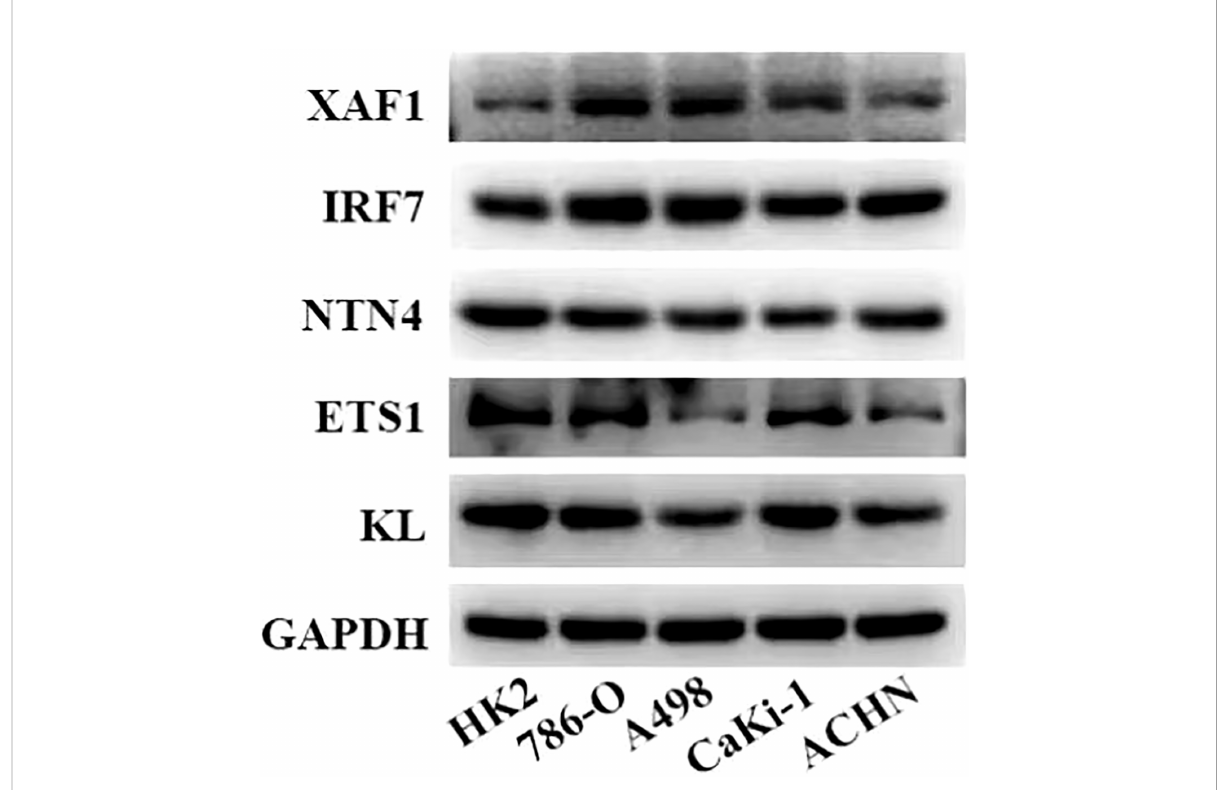
FIGURE 6 Expression levels of fi ve genes in the risk model in normal kidney cells and ccRCC cells measured by Western